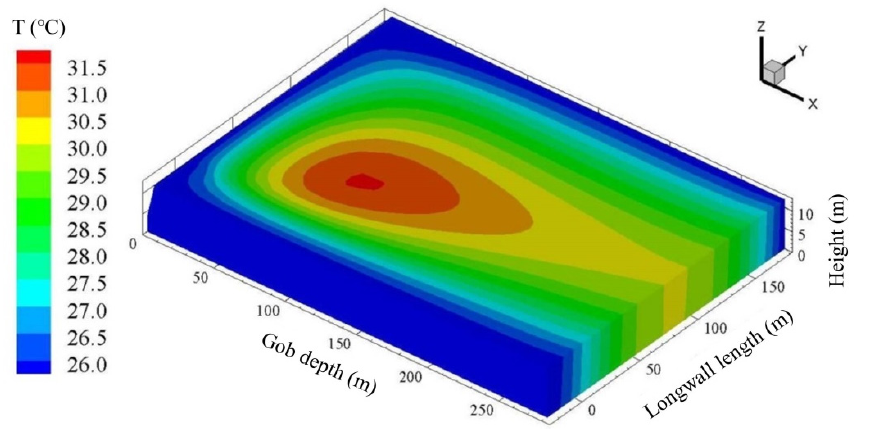
Figure 10. Simulation result of the temperature distribution in the goaf area.